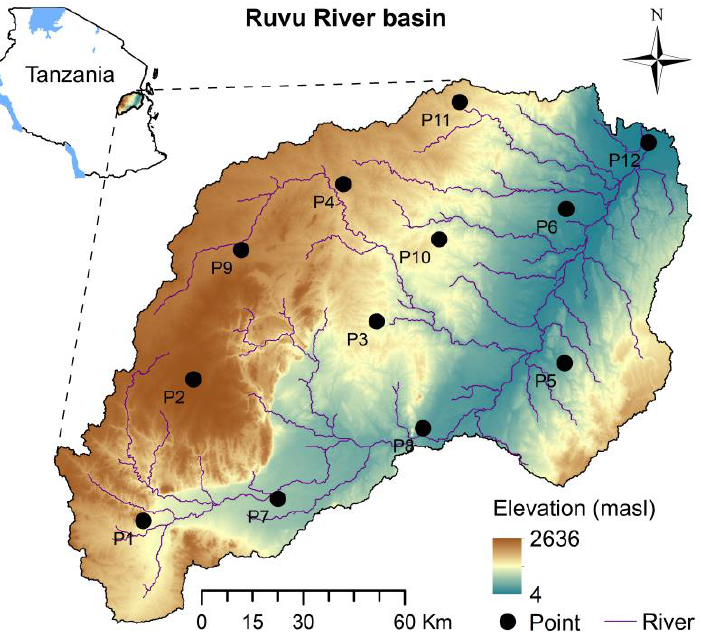
Figure 1. The Ruvu River basin showing elevation [23] and the points (P1 to P12) used to extract the time series of evapotranspiration and potential evapotranspiration from remote sensing im- ages.